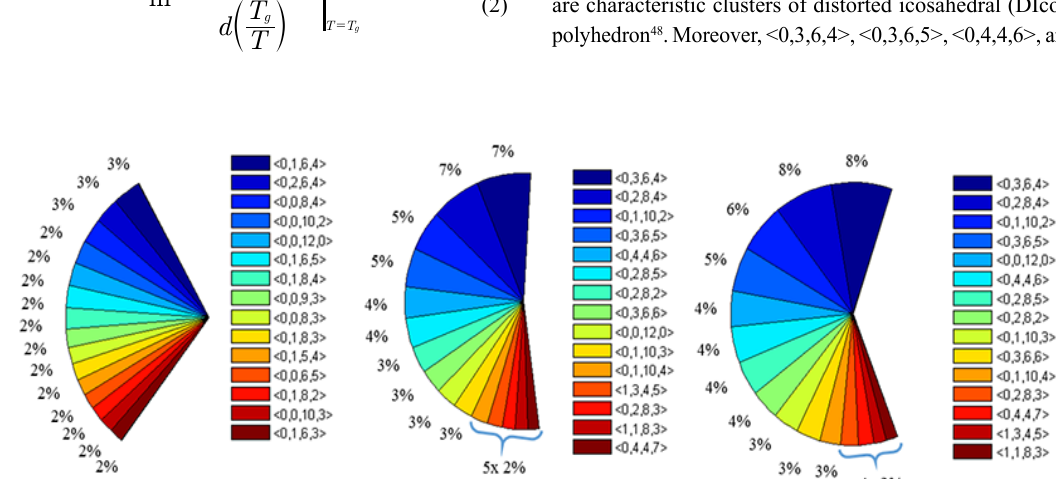
Zr Ti alloy. 60.0 32.5 7.5